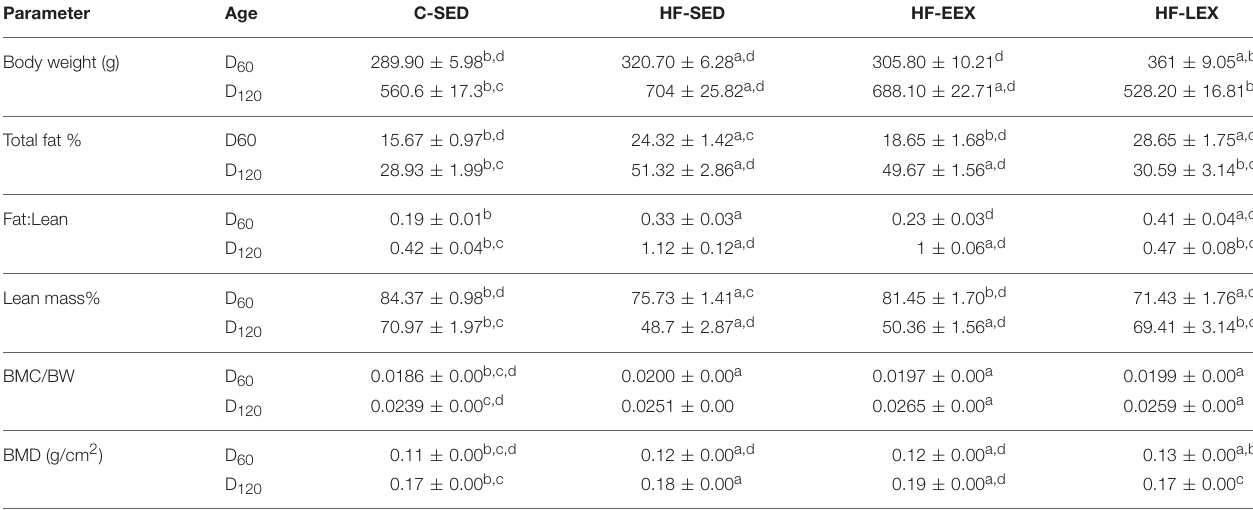
TABLE 1 | Rat body composition at D60 and D120. Parameter Age